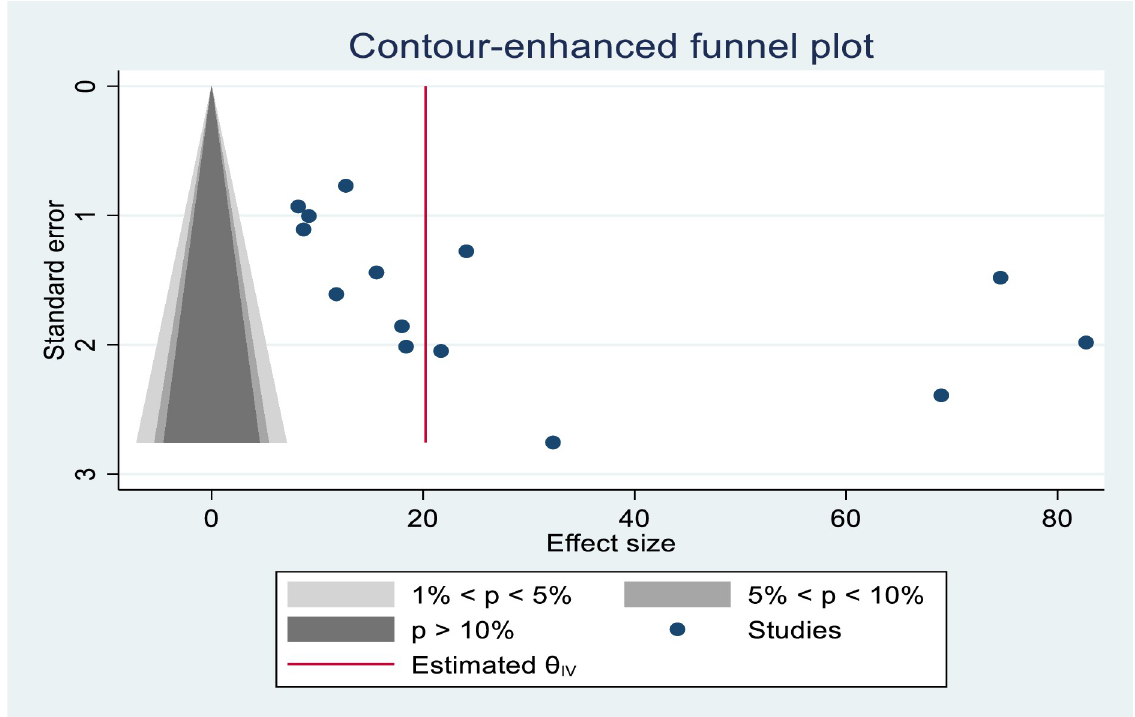
Fig 8. Association of tinea capitis with age of schoolchildren.